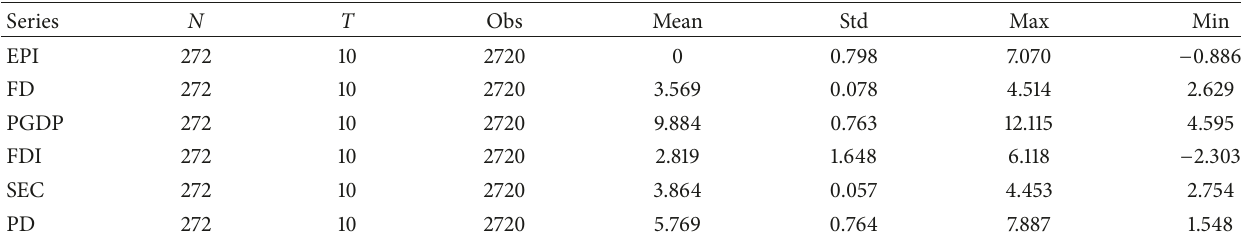
Table 3: Descriptive statistics of variables.